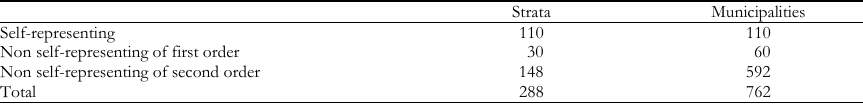
EU-SILC sampling design: Primary Sampling Units stratification (PPSs) – wave 2004